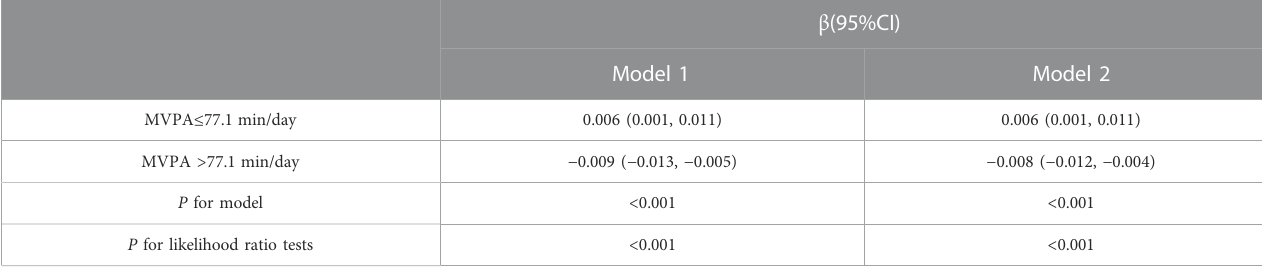
TABLE 4 Nonlinear dose-response and threshold-effect relationship analysis of MVPA and LDL-C